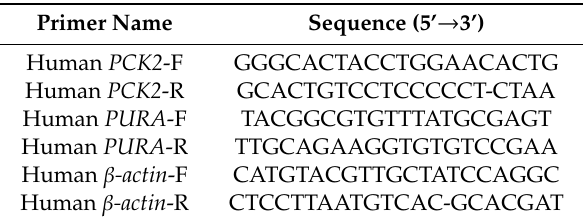
Table 1. Primers of the target